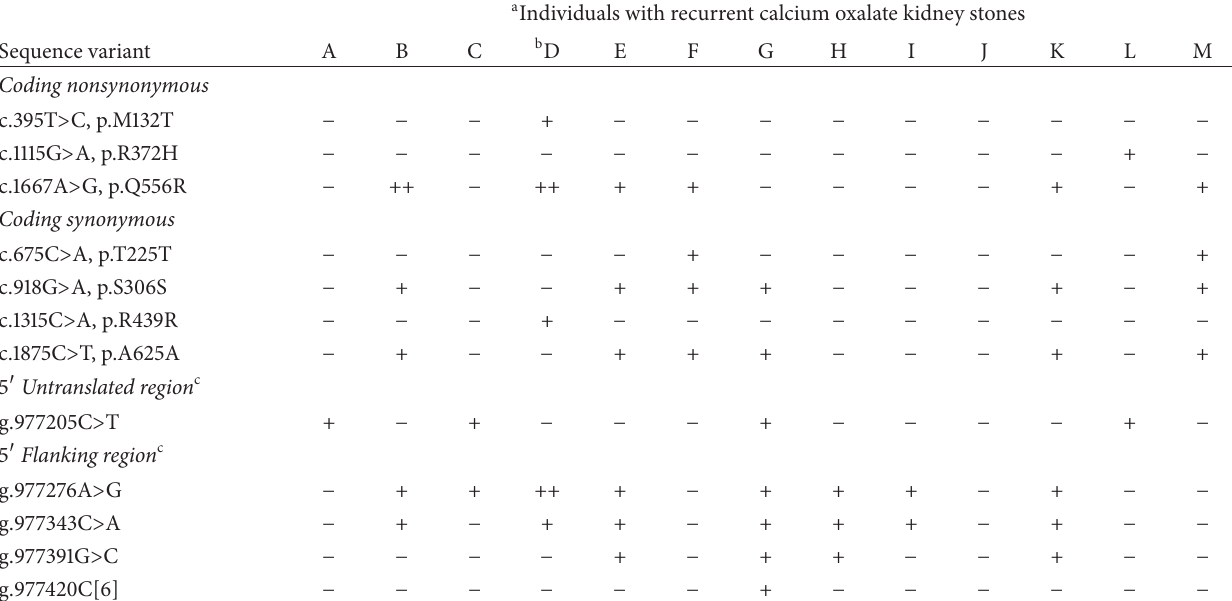
Table 2: SLC26A1 sequence variants identified in a cohort of recurrent calcium oxalate stone formers. a Individuals with recurrent calcium oxalate kidney stones